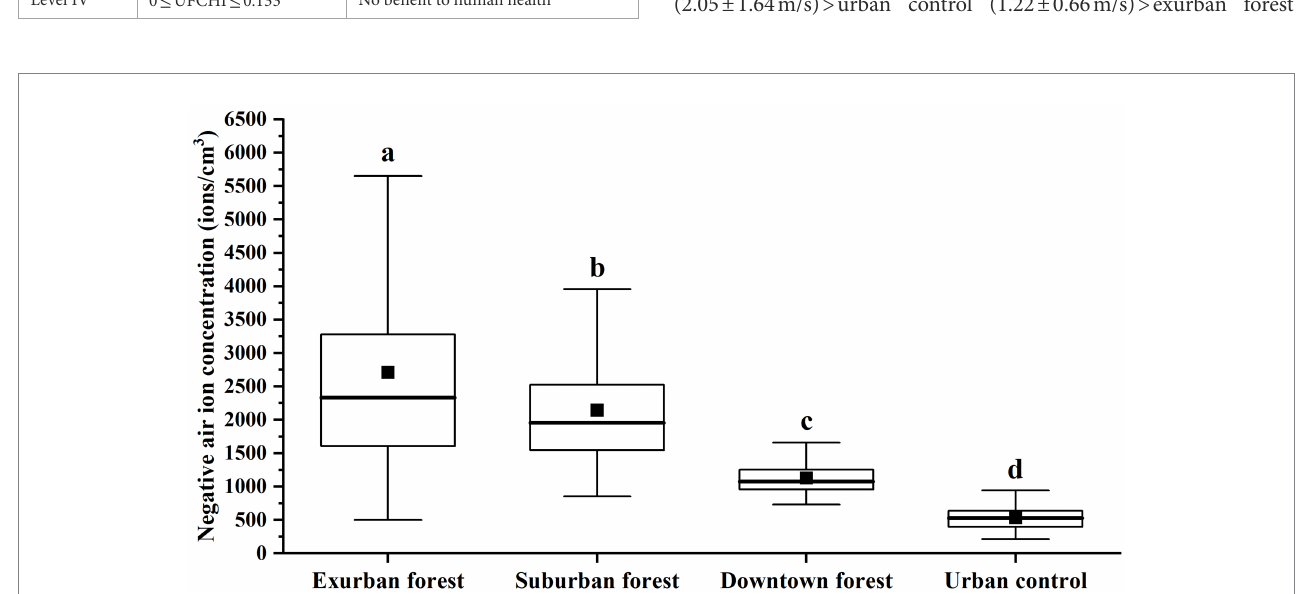
FIGURE 3 Comparison of annual average of NAIC of urban forests in different geographical spaces. The different lowercase letters indicate significant difference of urban forest in different geographical spaces ( p < 0.05).